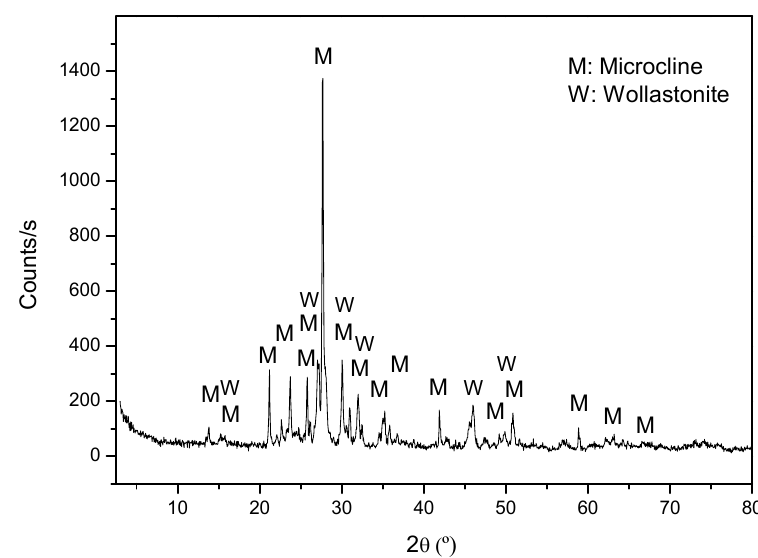
Figure 10. XRD pattern of the chlorination residue of the mixture KAlSi 3 O 8 / CaCl 2 calcined in N 2 at 900°C for 60 min.